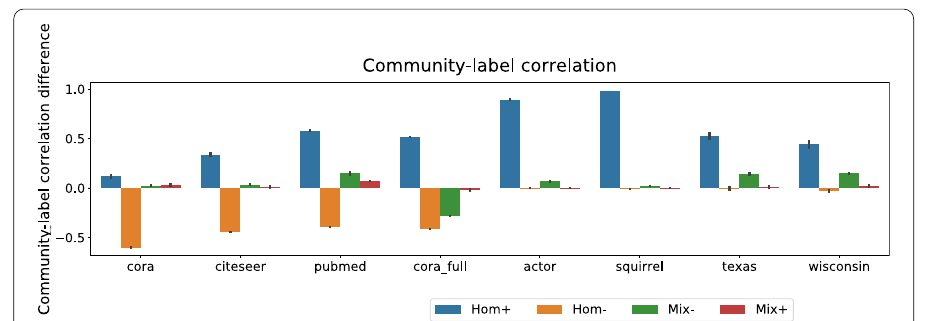
Fig. 6 Community-label correlation ( ρ ) on manipulated graphs. The bars represent the change in this correlation measure. We see that the change in correlation is high for homophilic graphs and low for non-homophilic graphs, following a pattern similar to homophily in Fig. 1. This measure was computed for the labeled nodes (train and validation sets) of each graph (original and manipulated) with ten different random